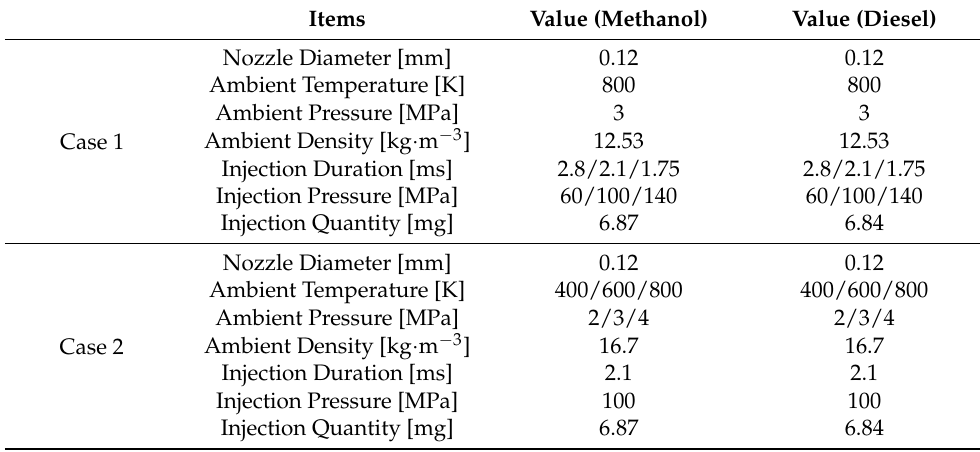
Table 2. Condition Settings of the Experimental